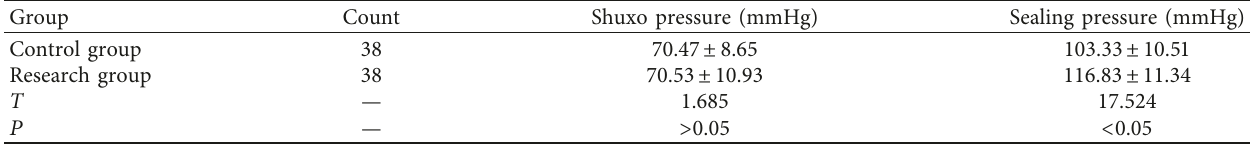
Table 1: Two sets of blood pressure contrast ( N , %).